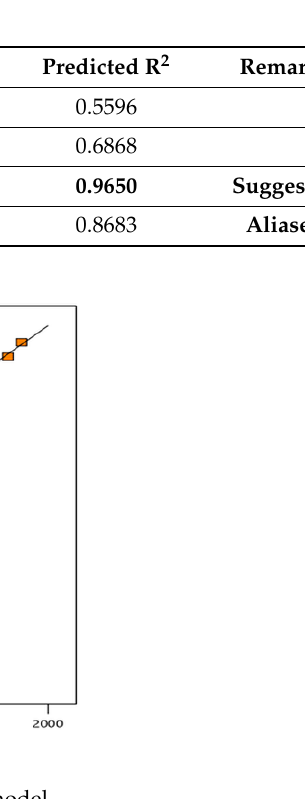
Figure 4. Power response graph of actual versus predicted